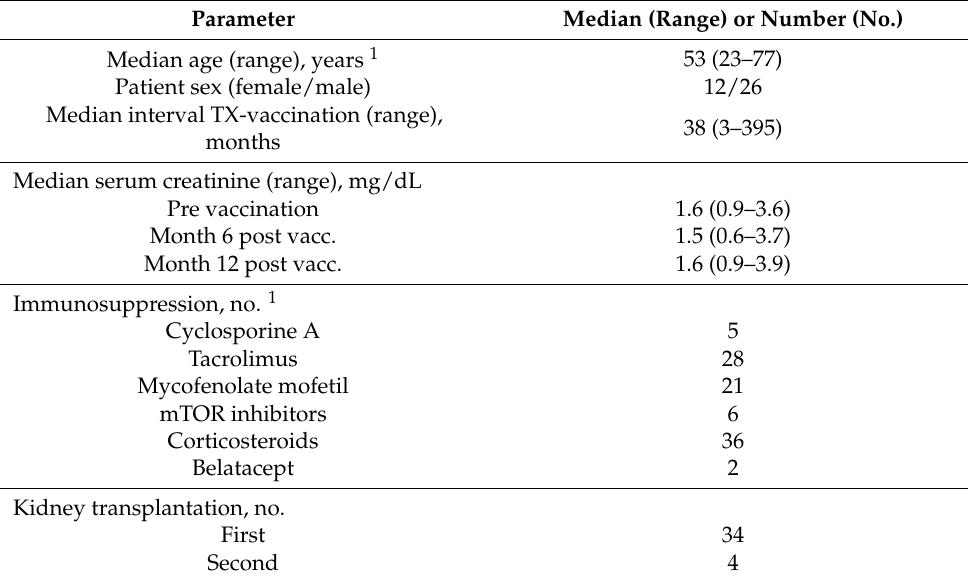
Table 1. Characteristics of 38 kidney transplant recipients vaccinated against S. pneumoniae